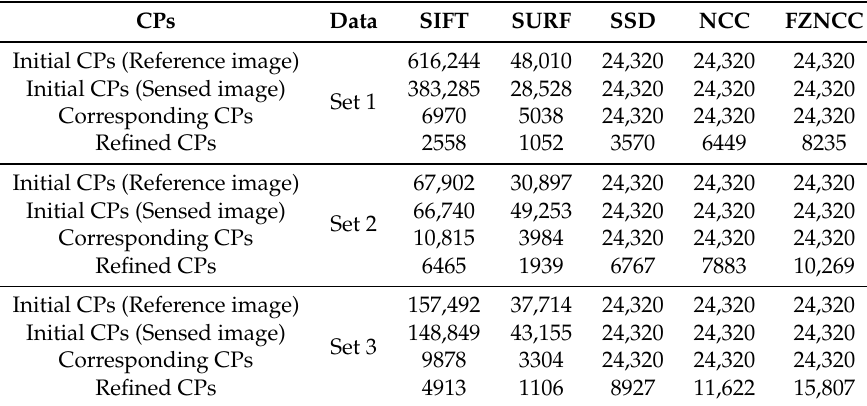
Table 1. Extracted CPs comparison.